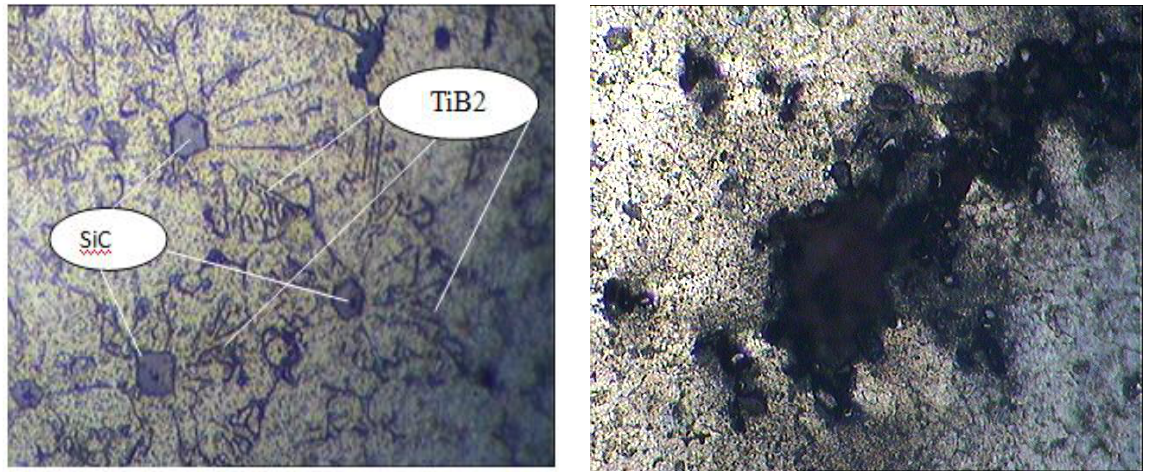
Figure 4. Micrographs of AA6061-SiC-TiB 2 composite.